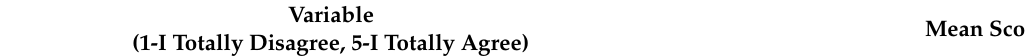
Table 5. The presence questionnaire summary.